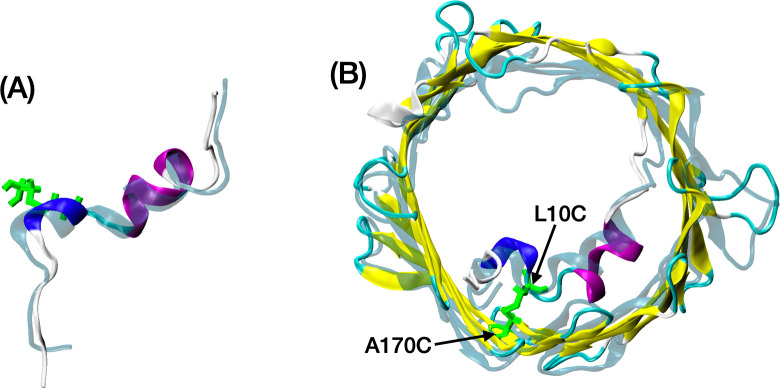
mVDAC1-Cys structure relaxed from 3EMN.mVDAC1-Cys conformation obtained after 10-ns-long equilibration of the (mutated) 3EMN crystal structure using ff14IDPSFF. The crystal structure is depicted in transparent turquoise. Disulfide bridge linked L10C and A170C residues are shown in green. (A) N-terminal region (side view); (B) whole channel (IMS view; the IMS is expected to correspond to the trans side in PLB experiments).